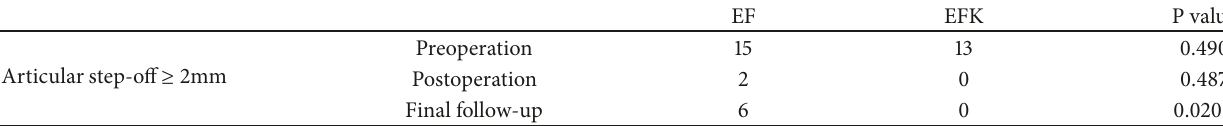
Table 3: Articular step-off assessment.